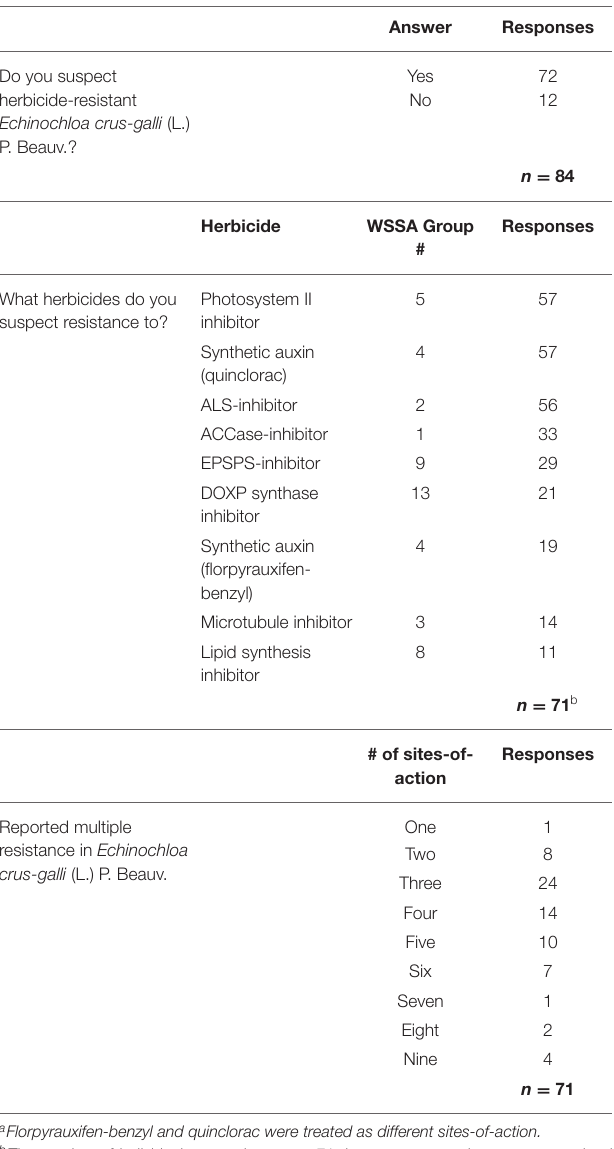
Answer Responses